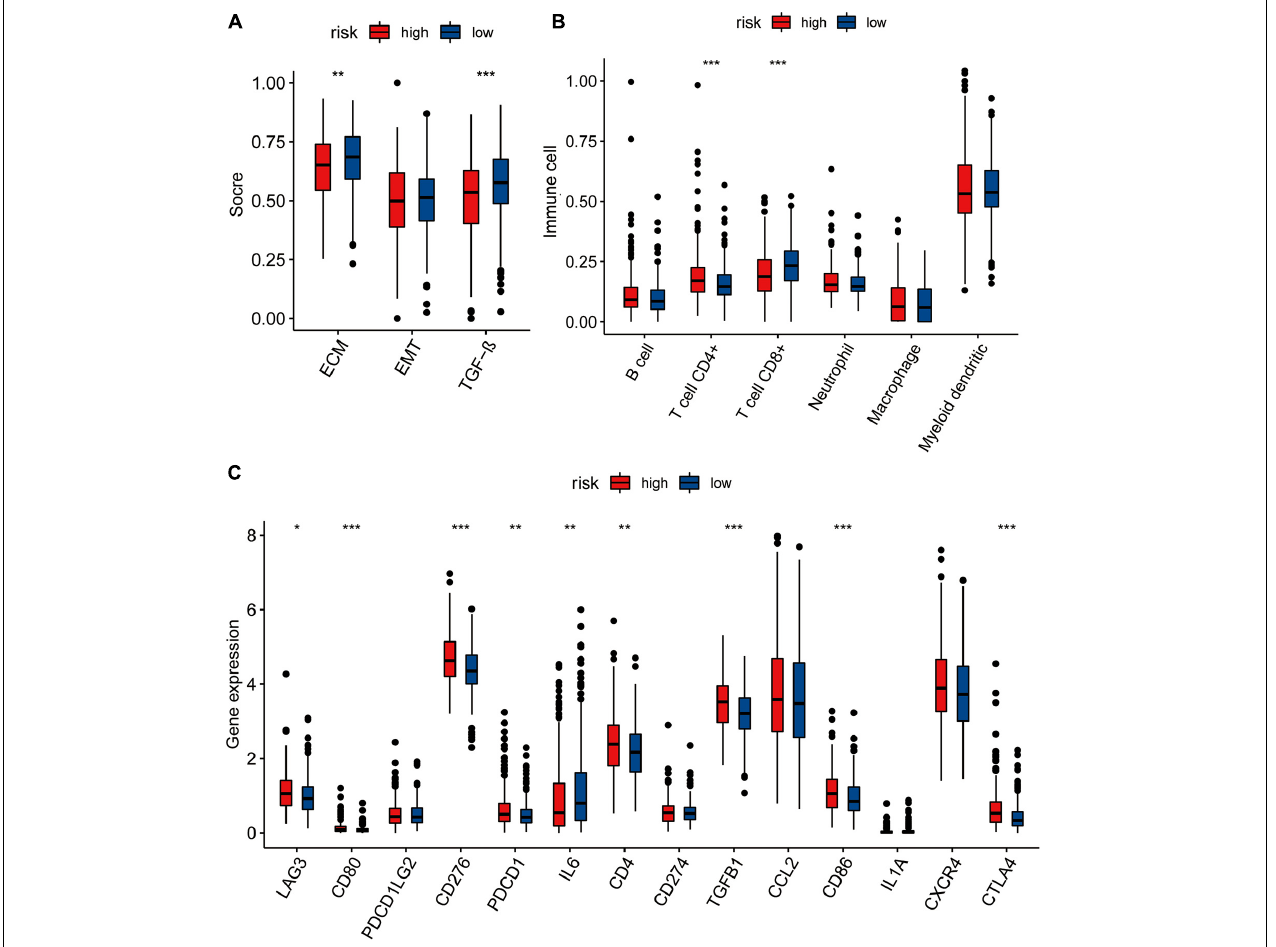
FIGURE 4 | (A) The pairwise comparison of the ssGSEA score of EMT ECM, and TGF-b between high- and low-risk group. (B) The differential analysis of the abundance of immune cells between high-low risk groups. (C) The differential analysis of checkpoints between high-low risk groups. The P values are labeled above each boxplot with asterisks (ns: represents no significance,* P < 0.05, ** P < 0.01, *** P <